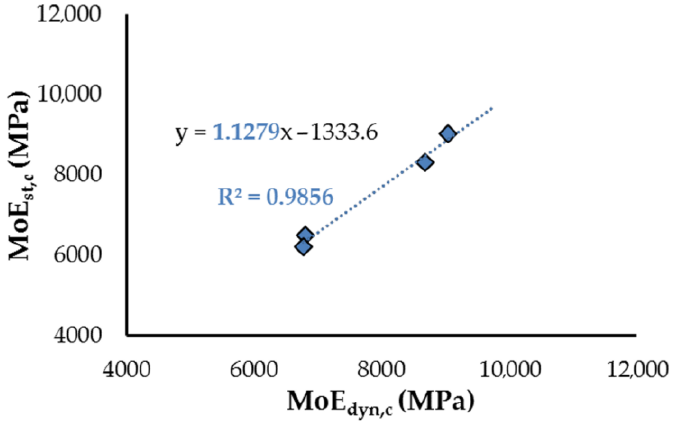
C14 Table 3. MoE st,c and MoE dyn,c comparison for the four beams tested to bending.